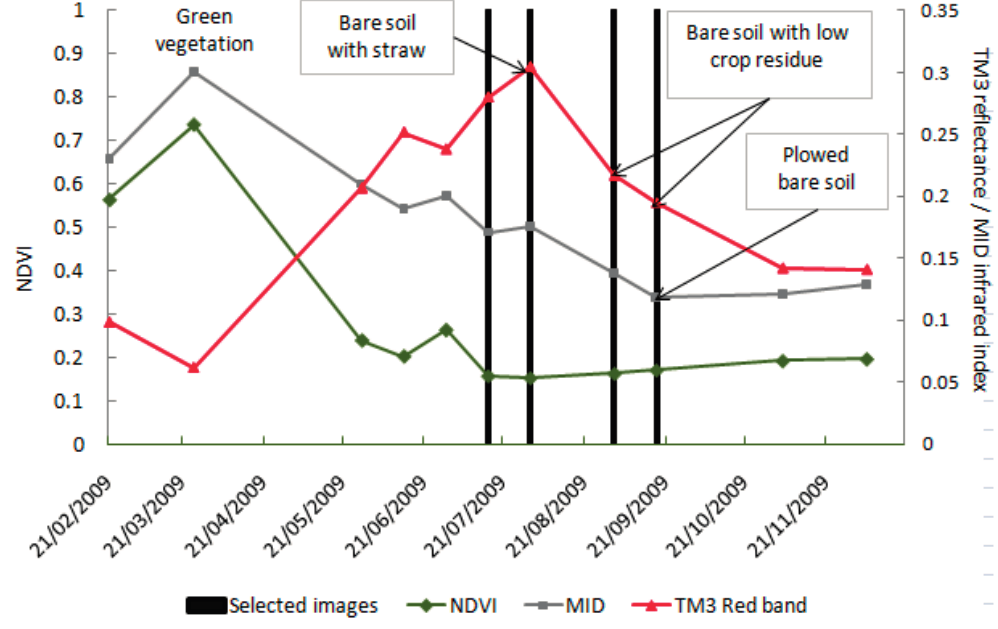
Figure 3. Example of Normalized Difference Vegetation index (NDVI), Landsat Red band (TM3) and MID-Infrared index profiles extracted from selected Landsat TM images, over a cereal test plot of 8 hectares (clayey soil texture) during the period ranging from 21 February 2009 until 21 November